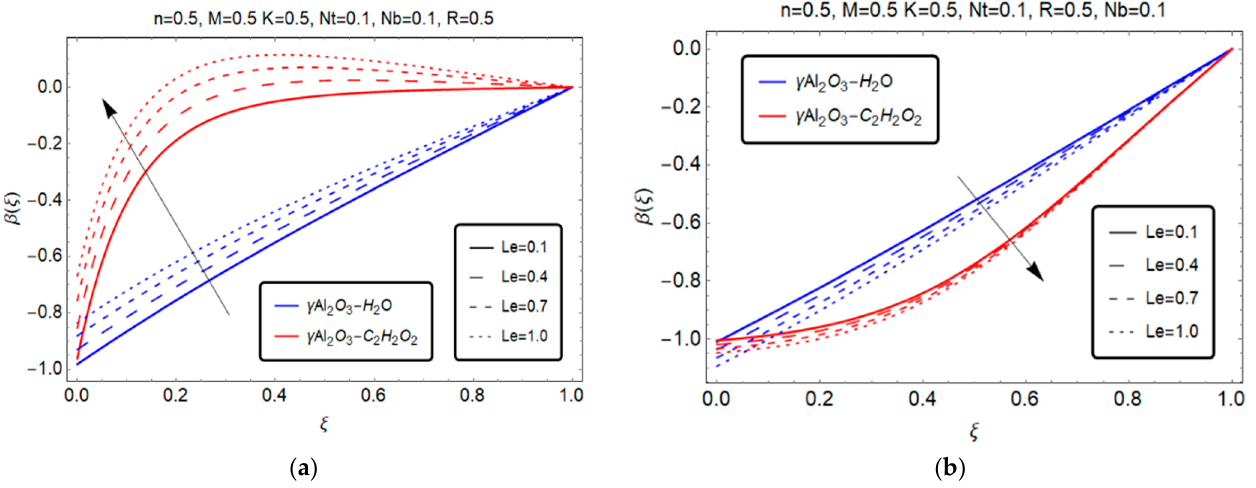
Figure 9. Effect of Lewis number 𝐿𝑒 on 𝛽(𝜉) . ( a ) S > 0; ( b ) S < 0.